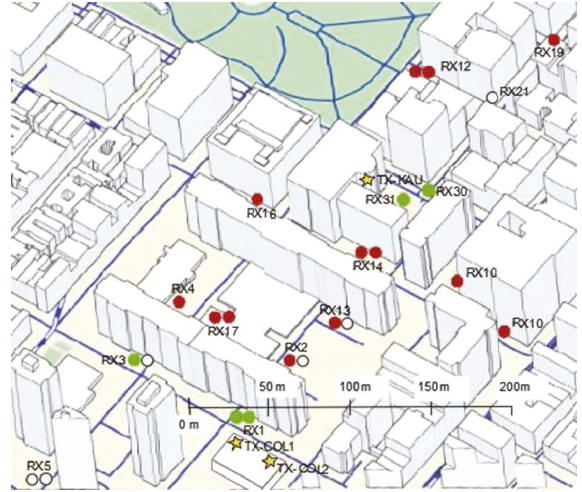
Figure 3: 3D building map of TX and RX locations around an urban area for 28GHz measurements; stars indicate TX locations and dots indicate RX locations.